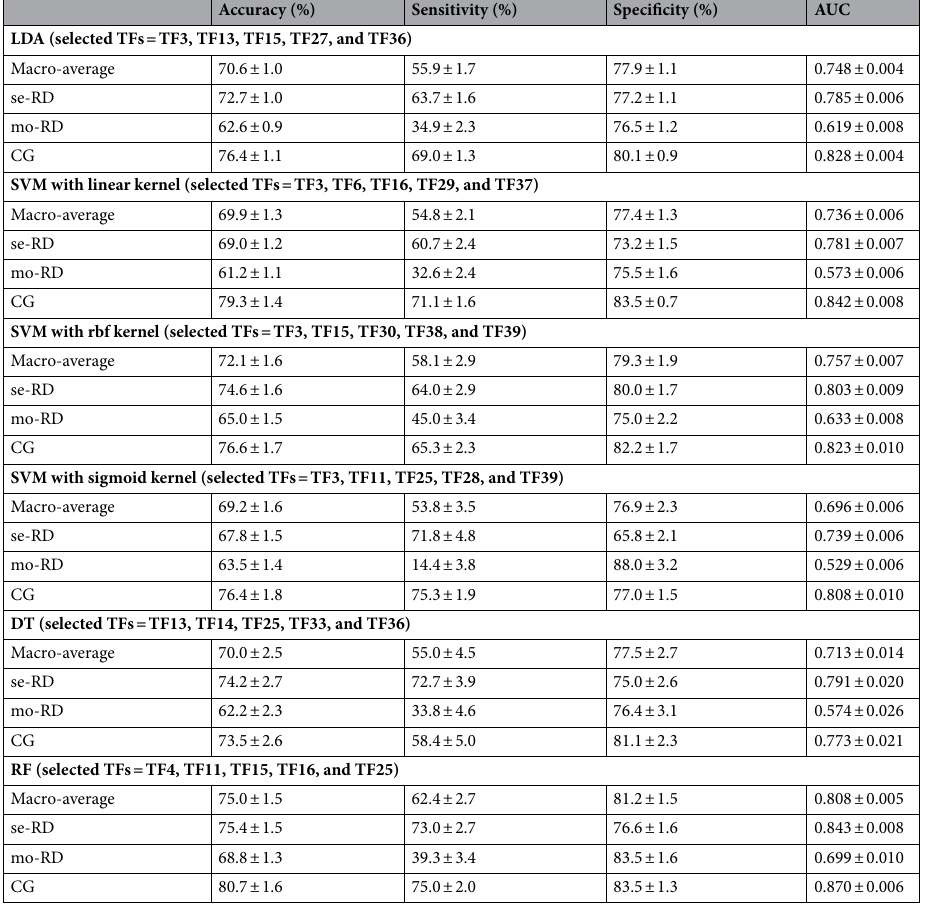
Table 6. Performance of each classification attempt in discriminating between the three groups in ADC map imaging. TF texture feature, DT decision tree, LDA linear discriminant analysis, SVM support vector machine, RF random forest classifier, AUC area under the curve, se-RD severe renal dysfunction (estimated glomerular filtration rate; eGFR < 30 mL/min/1.73 m 2 , i.e., CKD stage G4–5), mo-RD moderate renal dysfunction (30 ≤ eGFR < 60 mL/min/1.73 m 2 , i.e., CKD stage G3a/3b), CG control group (eGFR ≥ 60 mL/min/1.73 m 2